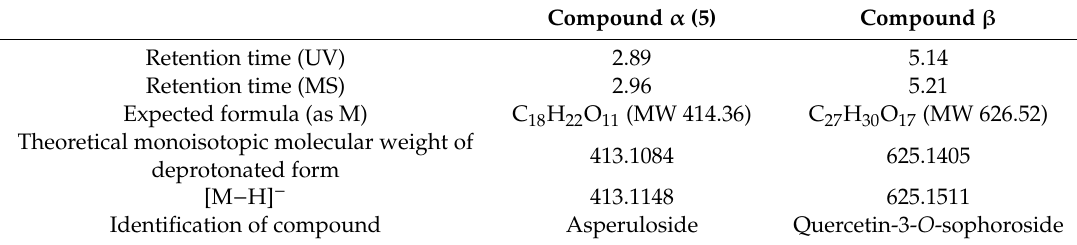
Figure 3. Chromatogram (HPLC) of H. diffusa extract ( A ) and UPLC connected QTOF-MS chromatogram of H. diffusa extract ( B ). Table 2. Qualitative analysis of compounds α and β by UPLC/QTOF-MS.